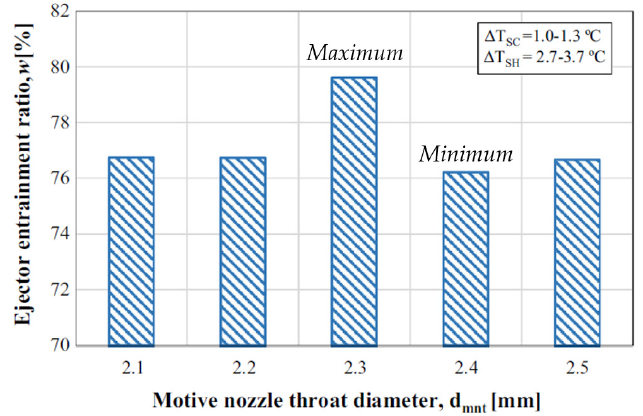
Figure 8. Effect of primary nozzle throat diameter on entrainment ratio [58]. Xue et al. [59] used a computational method to study the effect of three nozzles (conical, petalage and crenation nozzles) on performance of supersonic ejectors. Except for outlet shape, all other parameters are kept constant (area ratio, area of throat of mixing chamber to nozzle throat = 3.24, primary throat diameter = 10 mm, length of ejector’s throat is 6 times its diameter; 18 mm, with constant, exiting area). The study focused on critical, sub-critical and back flow operational modes where both back pressure and entrainment ratio were examined to explore the highest back pressure and entrainment ratios. Figure 9 is the plot for entrainment ratio versus back pressure, computed from the numerical study; at initial conditions, entrainment ratio is higher for crenation while at critical back pressure, petalage has highest entrainment as well as back pressure.